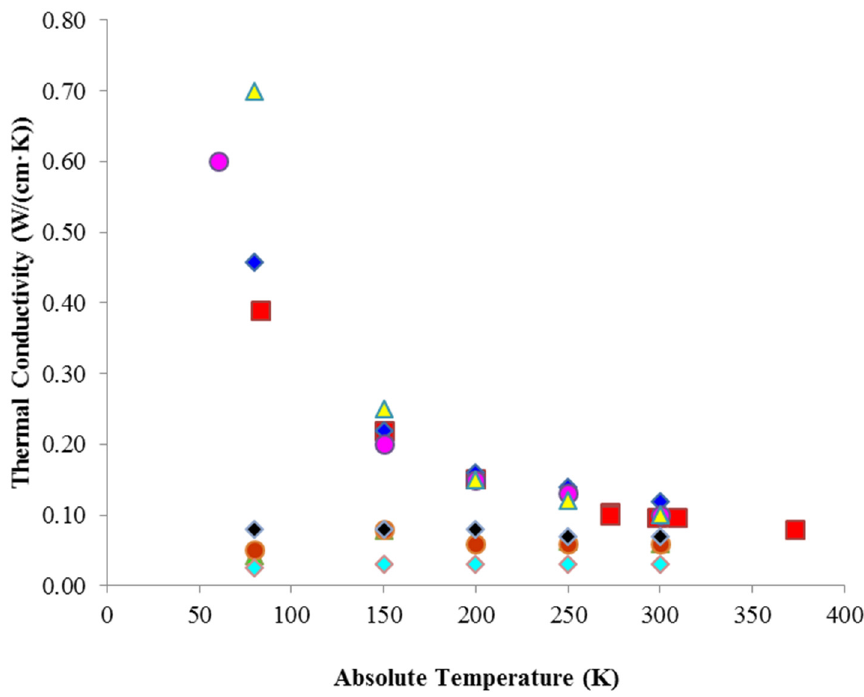
Figure 15. Thermal conductivity as a function of absolute temperature of the anaxial laser material CaF 2 , for undoped (red [52], blue [53], pink [45], yellow [54]), 1 (black [54]), 3 (orange [53], light blue [54]) and 5 (green [54]) at. % doped Yb cases.